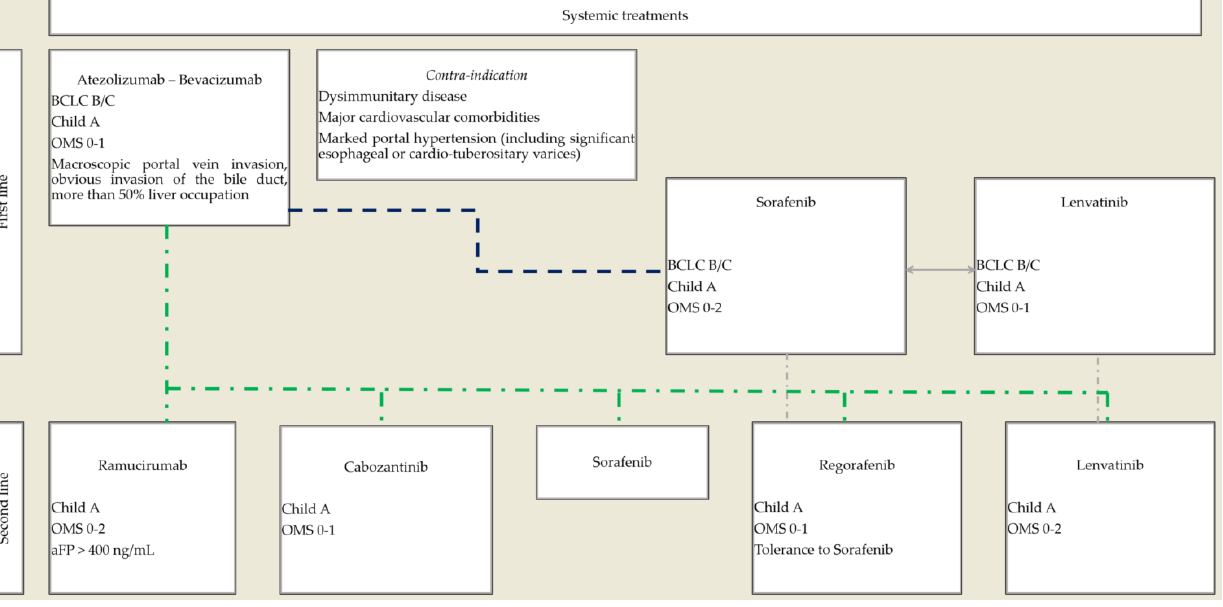
Figure 1. Proposed therapeutic algorithm for the use of systemic treatments in advanced, unresectable HCC.